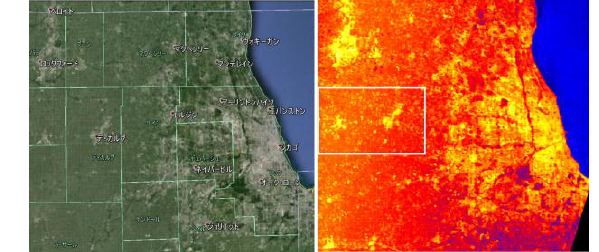
Figure 16. Daytime image of Chicago in the stats of Illinois